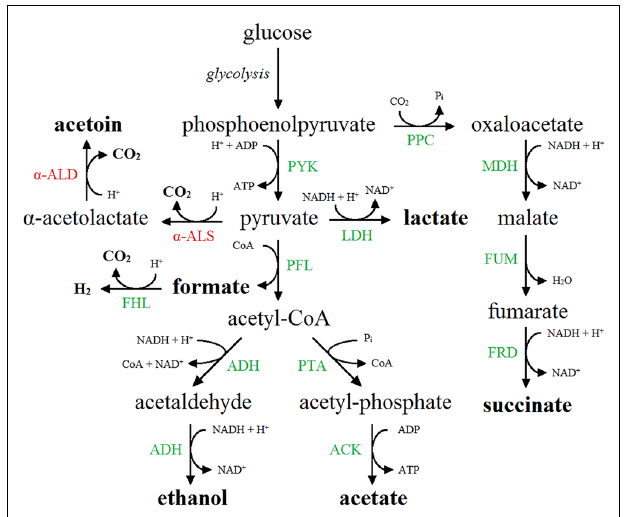
FIGURE 2 | Mixed-acid fermentation pathway in E. coli expressing the acetoin synthesis operon ( budAB operon). End products are shown in boldface. Native enzymes are shown in green.The enzymes of the additional acetoin synthesis pathway, in which pyruvate is converted to α -acetolactate by α -ALS (BudB) and further to acetoin by α -ALD (BudA), are shown in red. α -ALS, α -acetolactate synthase; α -ALD, α -acetolactate decarboxylase; ACK, acetate kinase; ADH, acetaldehyde dehydrogenase/alcohol dehydrogenase; FHL, formate hydrogen lyase complex; FRD, fumarate reductase; FUM, fumarase; LDH, lactate dehydrogenase; MDH, malate dehydrogenase; PFL, pyruvate formate lyase; PPC, phosphoenolpyruvate carboxylase; PTA, phosphate acetyltransferase; PYK, pyruvate